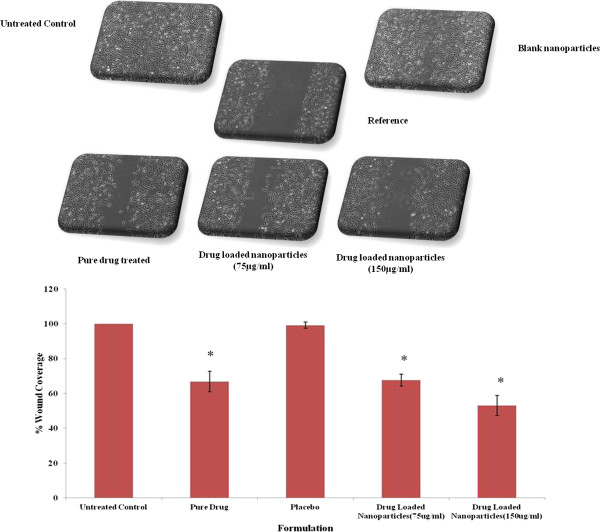
Wound Scratch assay to assess the role of developed nanoformulations on cellular motility. The wound coverage was found to be 66.84 ± 5.81, 67.59 ± 3.39 for TMZ and loaded nanoparticles at 75 μg/mL dose compared to the control (100%). A significant decrease in wound coverage at 150 μg/mL of nanoparticles concentration i.e 53.00 ± 5.82 is observed. However, no significant difference between placebo and control groups was observed (*P < 0.05).